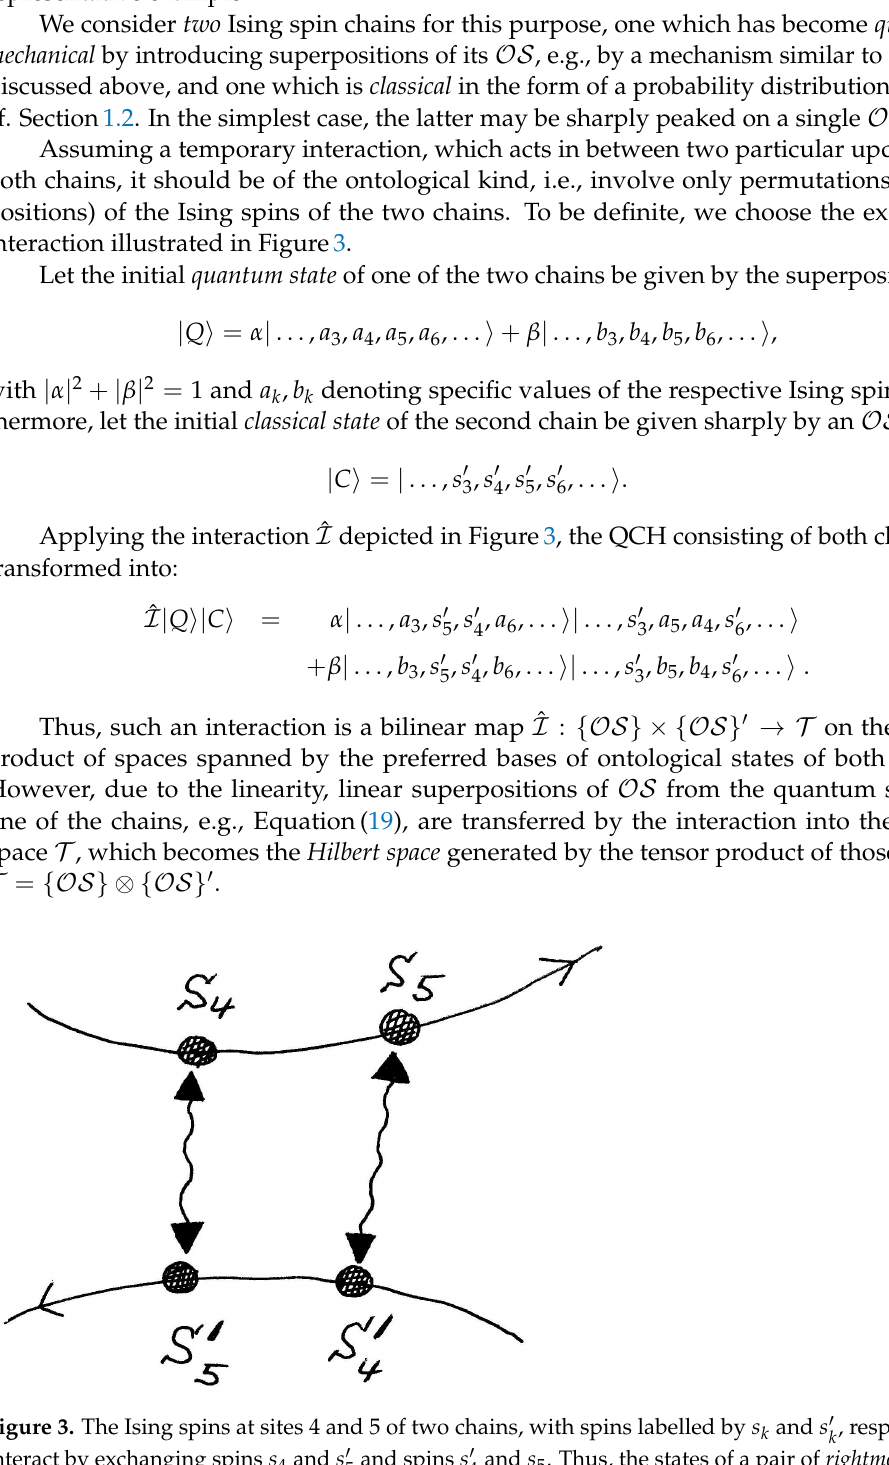
A curious case arises if both states in the superposition (19) differ only in one (or